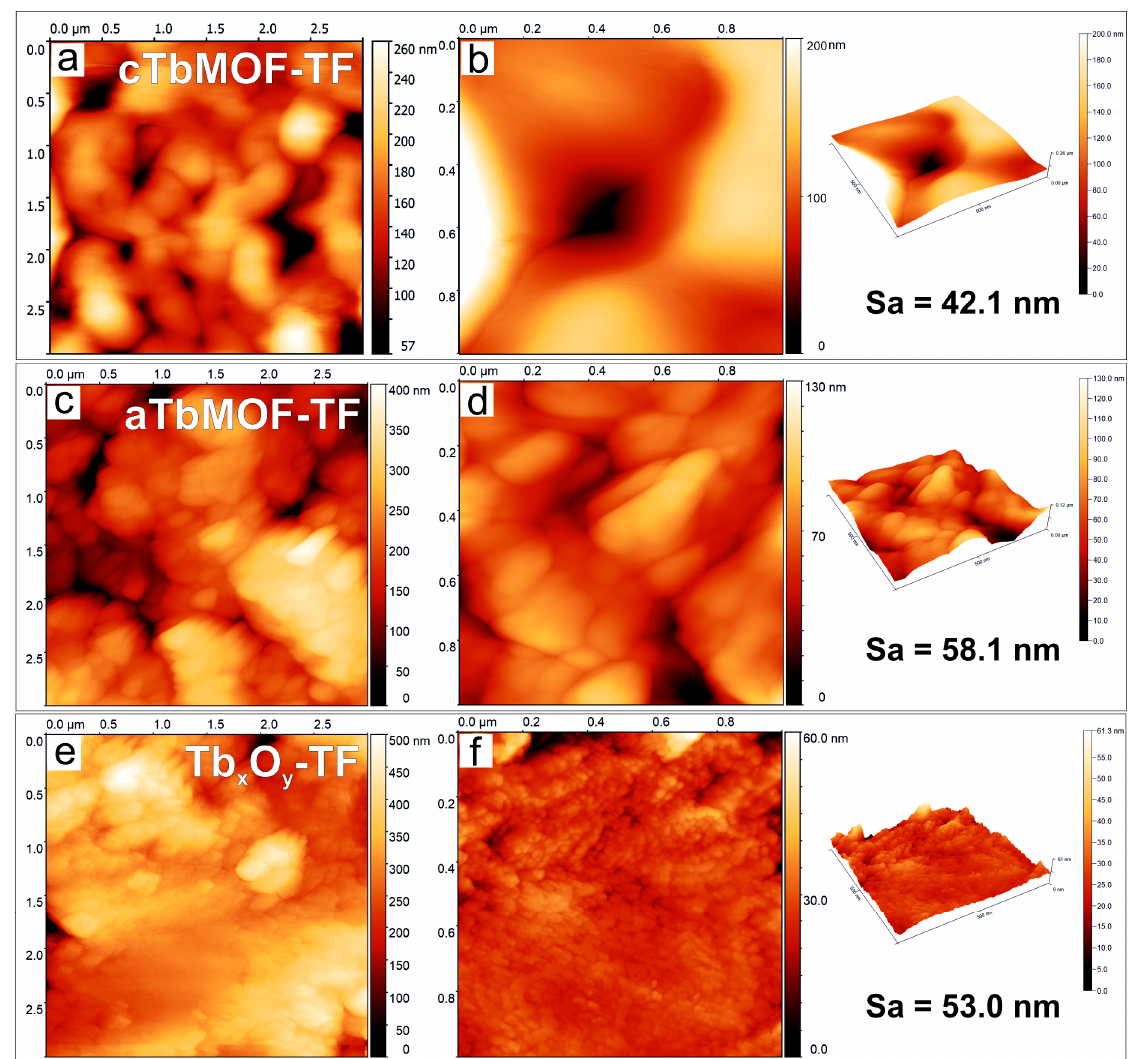
Figure 11. Two-dimensional and three-dimensional AFM surface topography microstructures of ( a , b ) cTbMOF-TF, ( c , d ) aTbMOF-TF, and ( e , f ) Tb x O y -TF thin films at different scale areas from 3 × 3 μ m 2 to 1 × 1 μ m 2 with average roughness Sa.